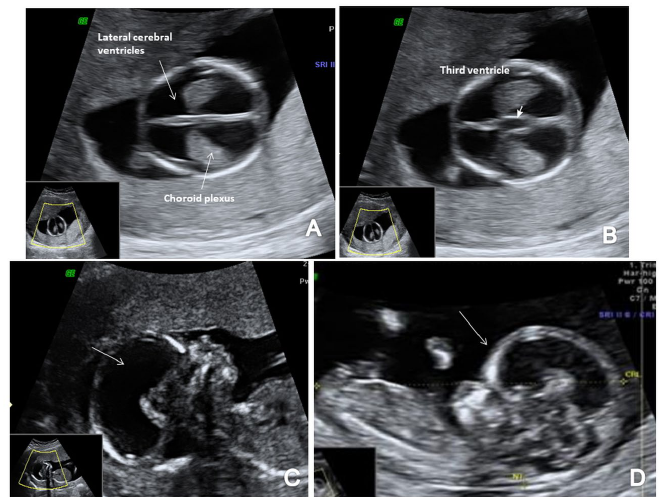
Figure 8. First-trimester ultrasound images of a fetus with hydrocephaly (Case 11): ( A ) enlarged cerebral ventricles with shrinked choroid plexus (axial view); ( B ) increased third ventricle (axial view); ( C ) abnormal sagittal view with increased forth ventricle and cisterna magna (arrow); ( D ) sagittal view with an important disproportion between head and body and frontal bossing (arrow).